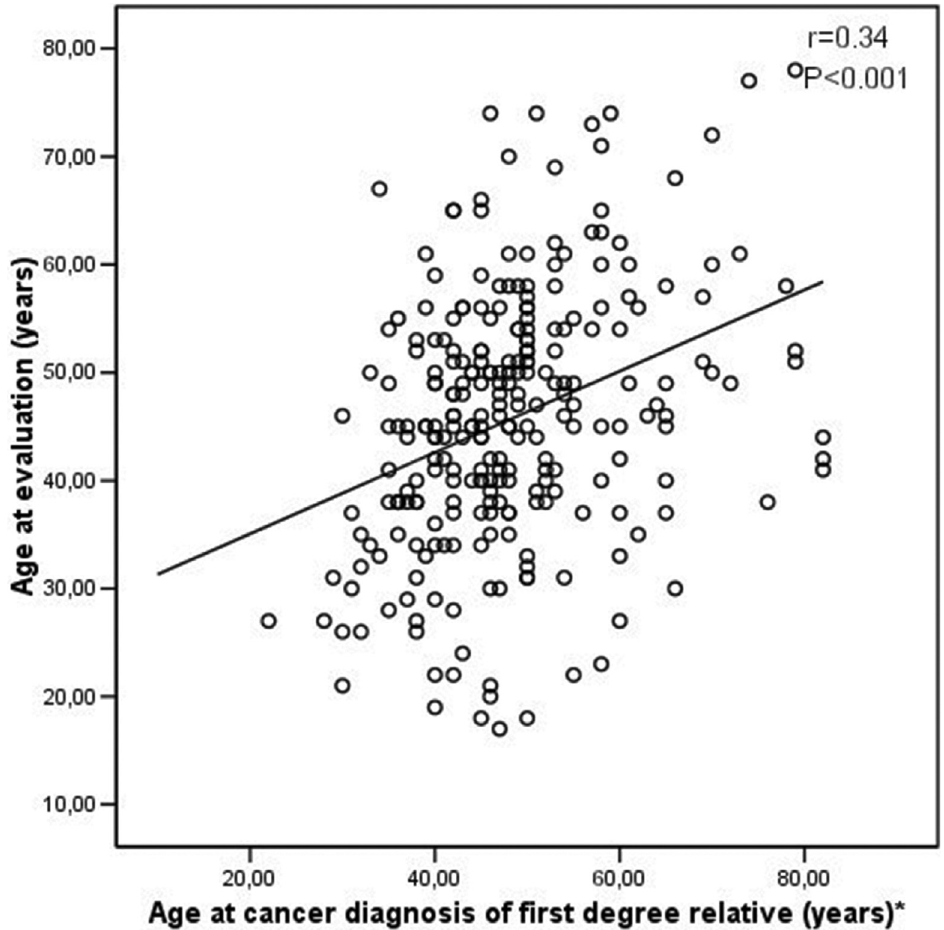
Figure 1 - Correlation between individuals age at first CGC session and age of cancer diagnosis in closest